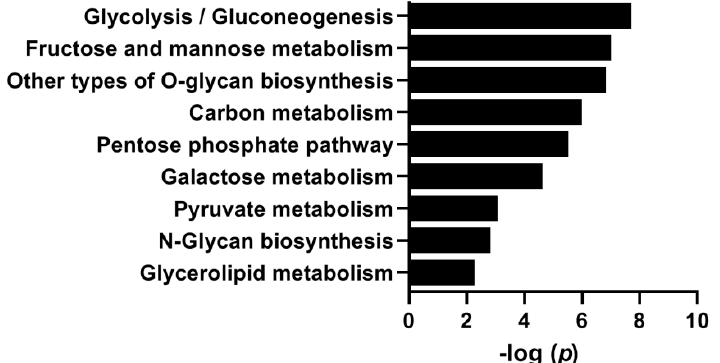
Figure 4. Pathways involved in metabolic processes regulated by hyperglycemia. Myotubes were exposed to 20 mM glucose (HG) or normal glucose concentration (NG) for the last four days of the differentiation period. Gene expression was measured using the Illumina HumanWG-6 v3.0 expression BeadChip (microarray). Pathway-ANOVA was performed to identify pathways regulated by HG compared to NG in myotubes from three donors (n = 3). Selected significantly (FDR p < 0.05) regulated pathways with relation to carbohydrate metabolism are presented.